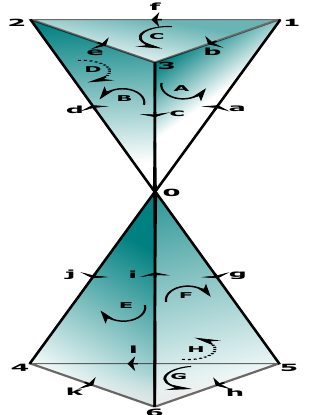
Figure 23 (VC) is homeomorphic to the representation presented below. The cup products of the cocycles deduced from this figure are presented in Table A4.